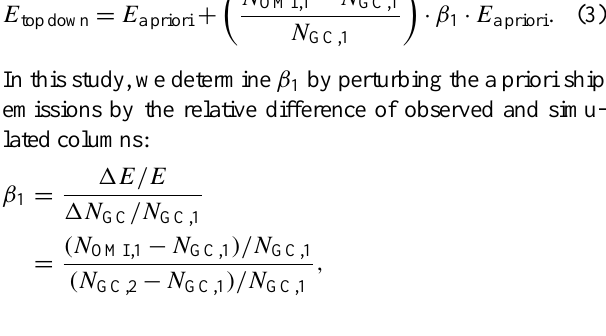
∗ Relative difference, β and γ are calculated over the areas defined in Fig. 6c. Emission strengths are summed over the constrained ship tracks as indicated in Fig.